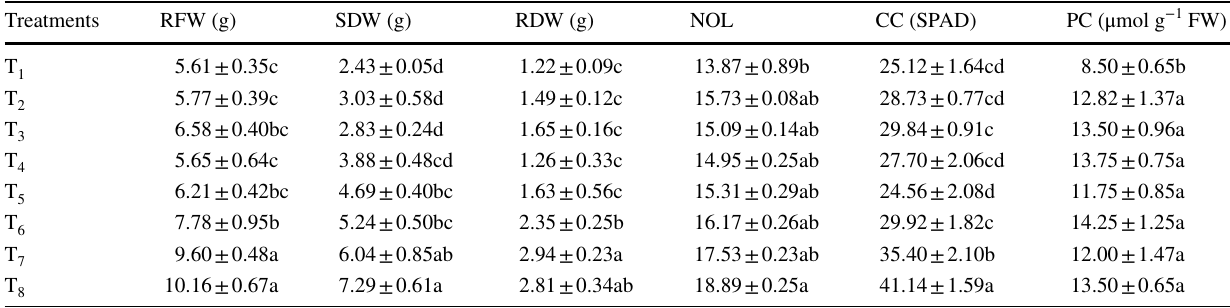
Table 3 Effect of different growing media on morpho-physiological and biochemical attributes of cucumber